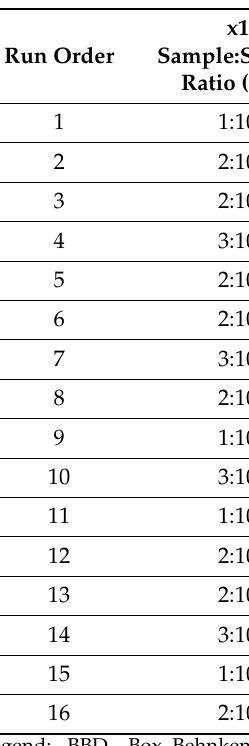
Table 1. Actual values of the independent variables in BBD and experimental